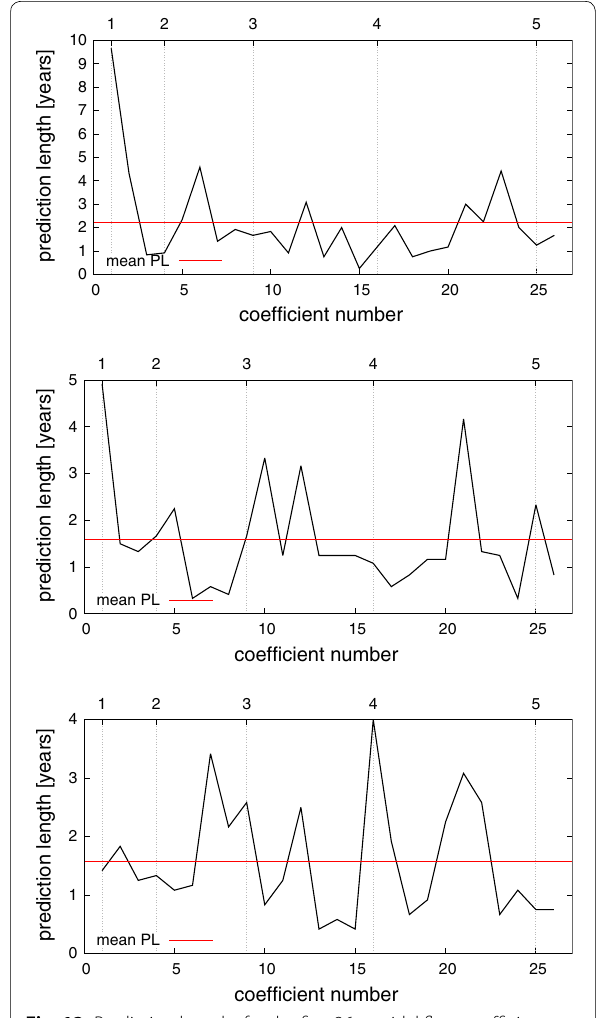
Fig. 12 Prediction lengths for the first 26 toroidal flow coefficients estimated from different forecast experiments with forecasts started in 1995 (top panel), in 2005 (middle panel) and in 2015 (bottom panel), respectively. The solid horizontal red lines represent mean prediction lengths in years derived from the first 26 toroidal flow coefficients. Top axes indicate degrees of the spherical